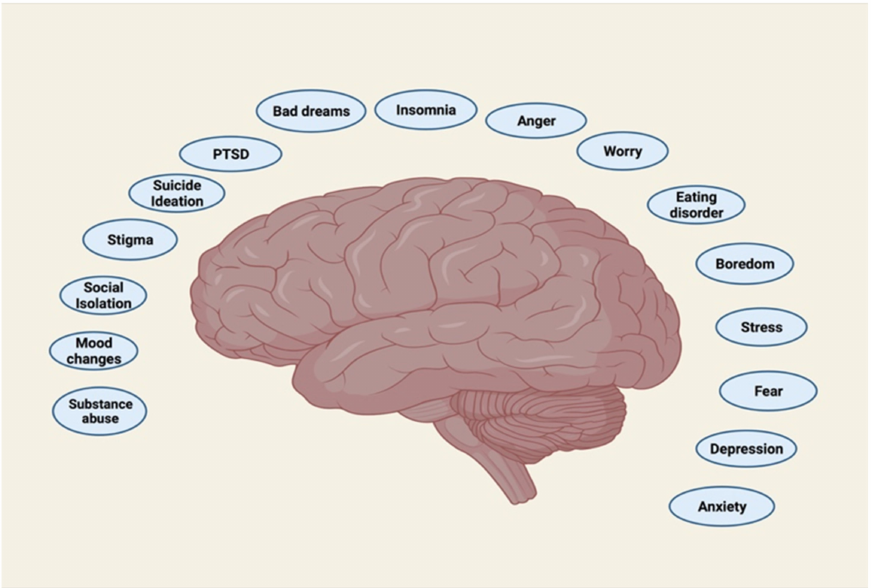
Figure 2. Mental disorders and impacts of lockdown associated with